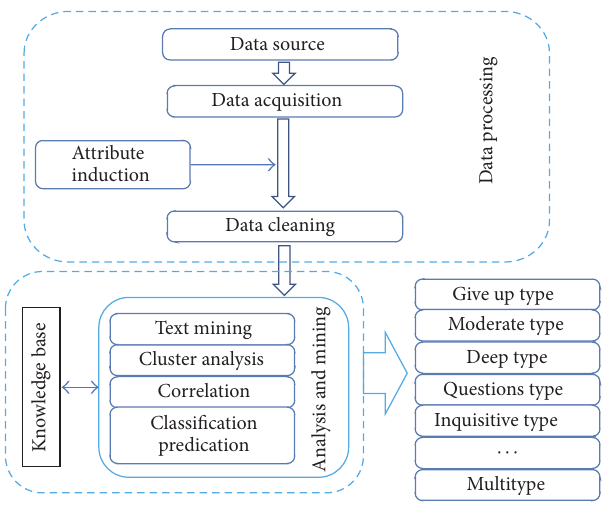
Figure 2: Student profile